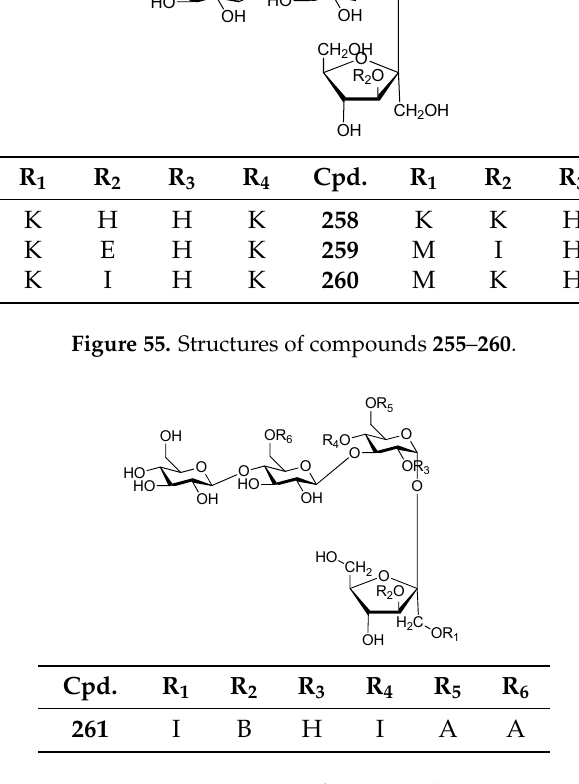
Figure 56. Structure of compound 261 .